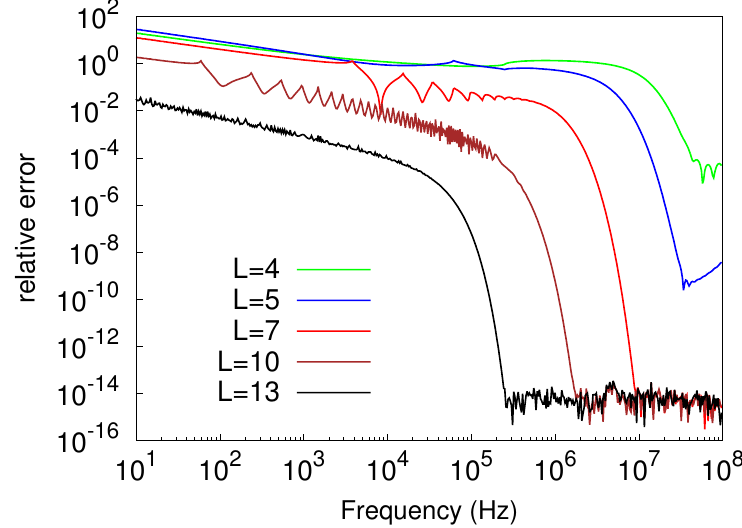
Figure 8. Relative error of (23) as compared to G7-K15 scheme, plotted against frequency. Table 2. Estimated OC and AEC for the sequence { H